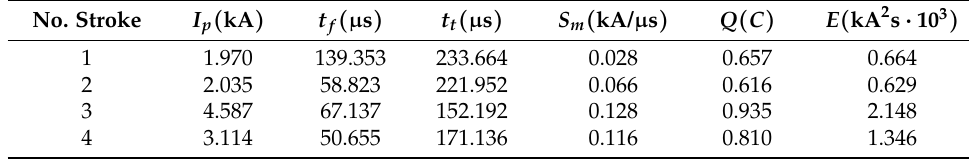
Table 10. Parameters for recorded positive